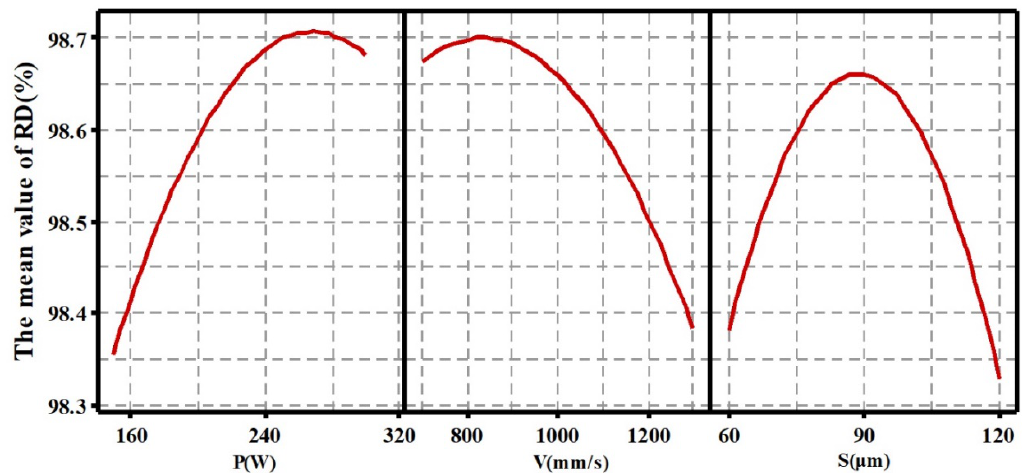
Figure 2. Main effects of processing parameters on relative density (RD).